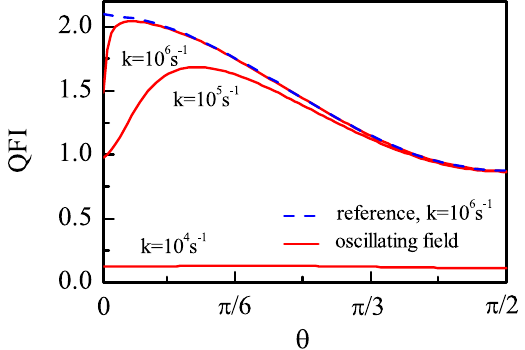
Figure 2. The QFI as a function of direction angle θ with a weak resonant oscillating field perpendicular to Earth’s magnetic field. . The blue dashed line provides a reference of QFI without the oscillating field for µ = B 46 T (The reference is independent of the recombination rate k when 0 ≤ − k